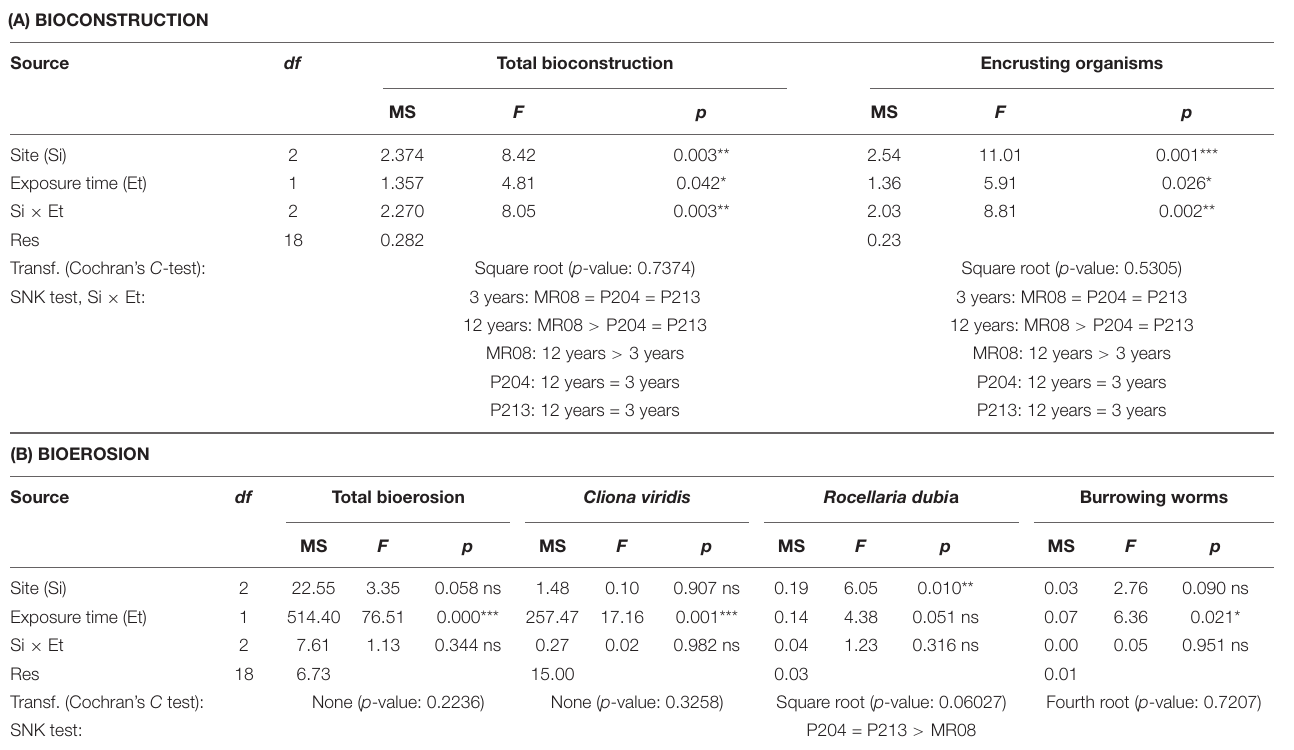
TABLE 2 | Results from ANOVA tests on bioconstruction (A) and bioerosion (B) in terms of kg m − 2